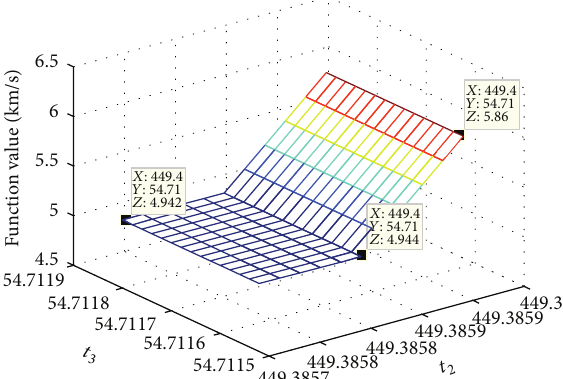
Figure 5: Relationship between function value change and variables 𝑡